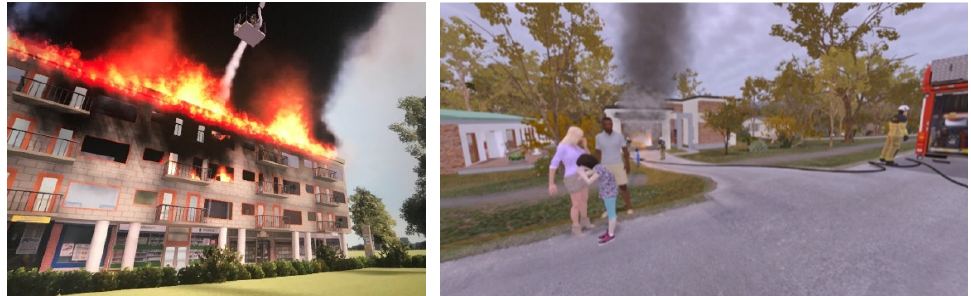
Figure 4. Example of how the IC-students’ view may be at an incident involving an apartment fire where the fire has spread to the roof ( left ), and at an incident involving a fire in the garage attached to a family house ( right ).